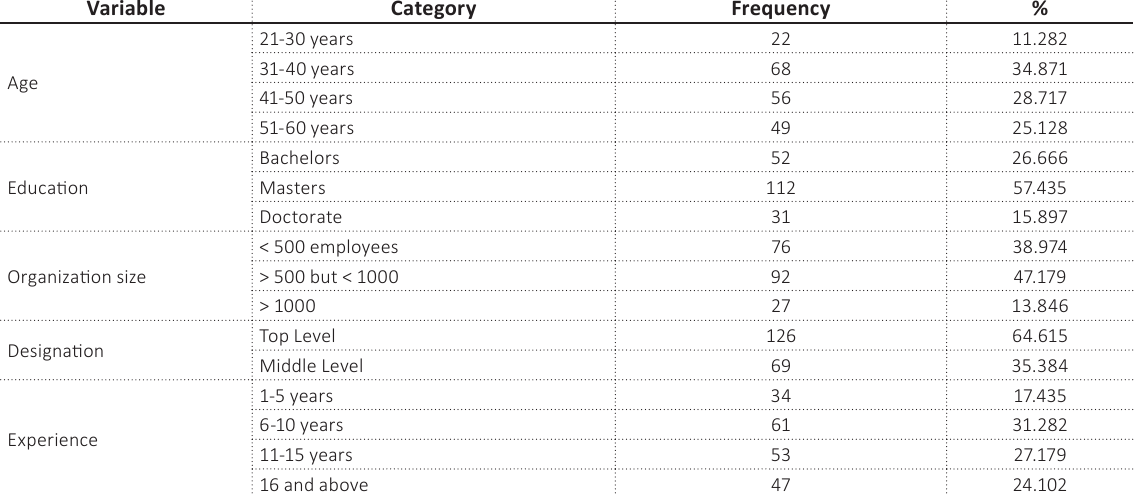
Table 2. Demographic data of